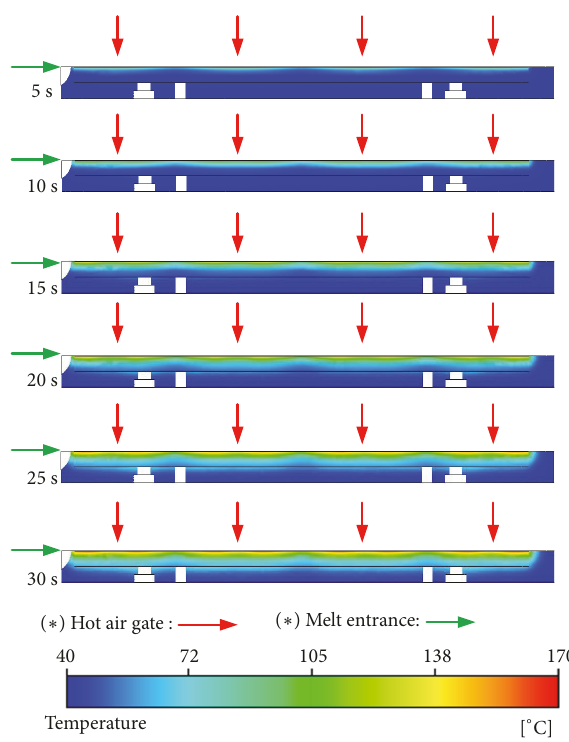
Figure 12: Temperature distribution at the cross section A-A with the gas heating of 400 ∘